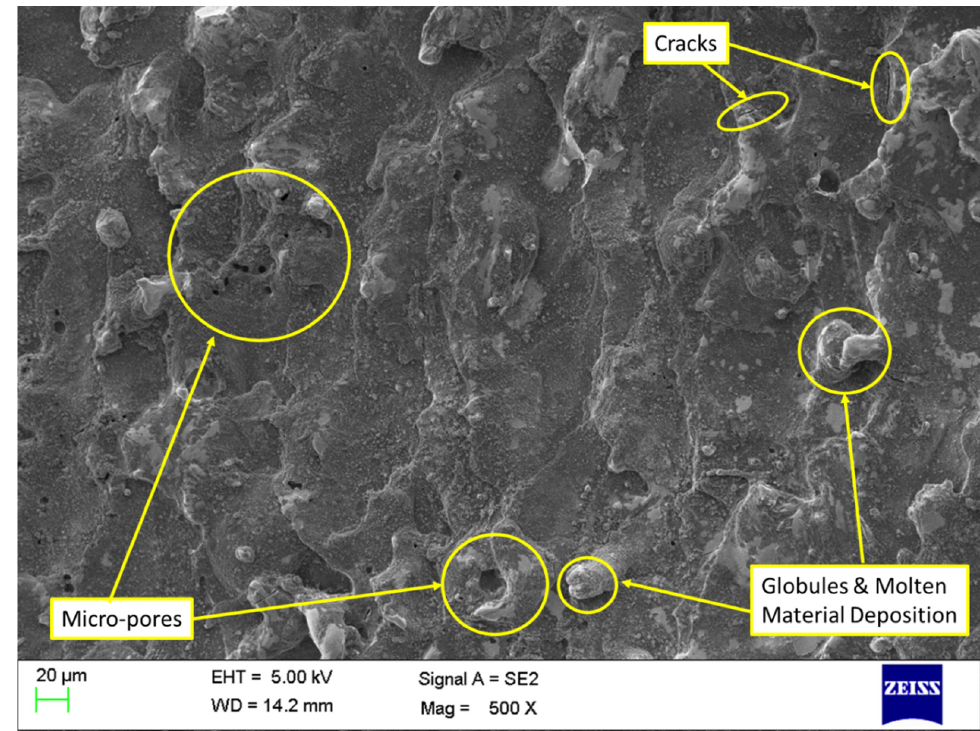
Figure 10. Analysis of machined surface for conventional WEDM (without MWCNTs).